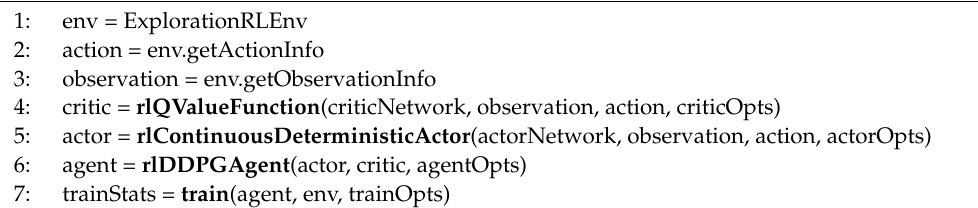
Algorithm 2: The DDPG agent for the mobile-robot exploration environment